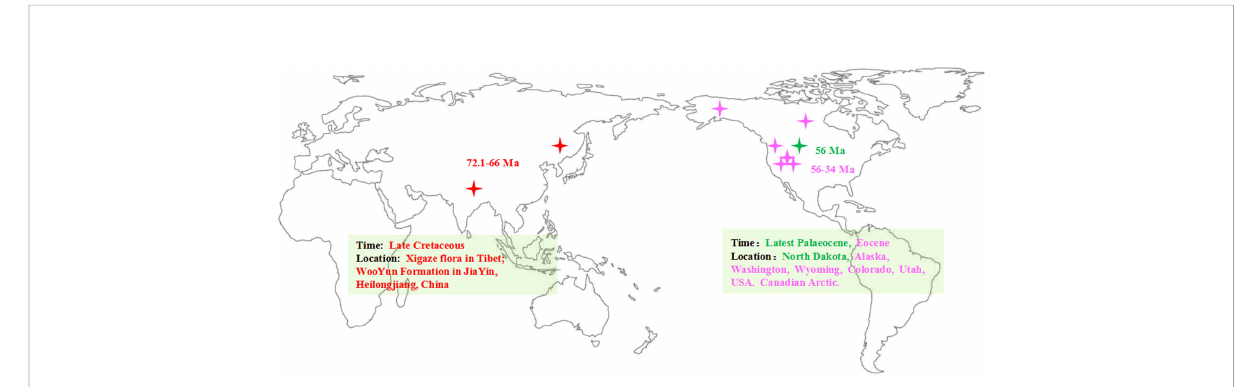
FIGURE 1 Mapof theearlierfossil distributionof thegenusPopulus(the map adapt fromHaoetal., 2015). Theasteriskrepresentedthe locationof